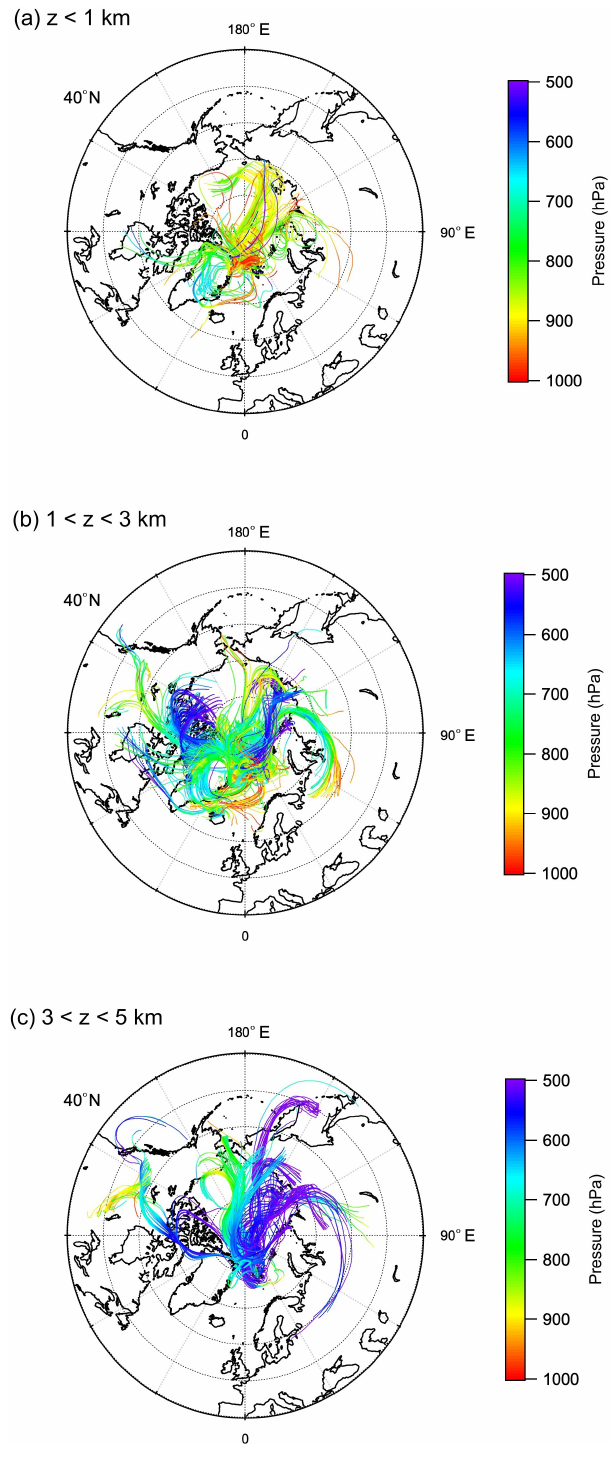
Figure B1. Six-day kinematic back trajectories of air parcels mea- sured aboard the aircraft. Color scales denote the pressure altitude of air. (a) Trajectories starting from altitudes z< 1km. (b) Same as (a) but for 1 <z< 3km. (c) Same as (a) but for 3 <z<